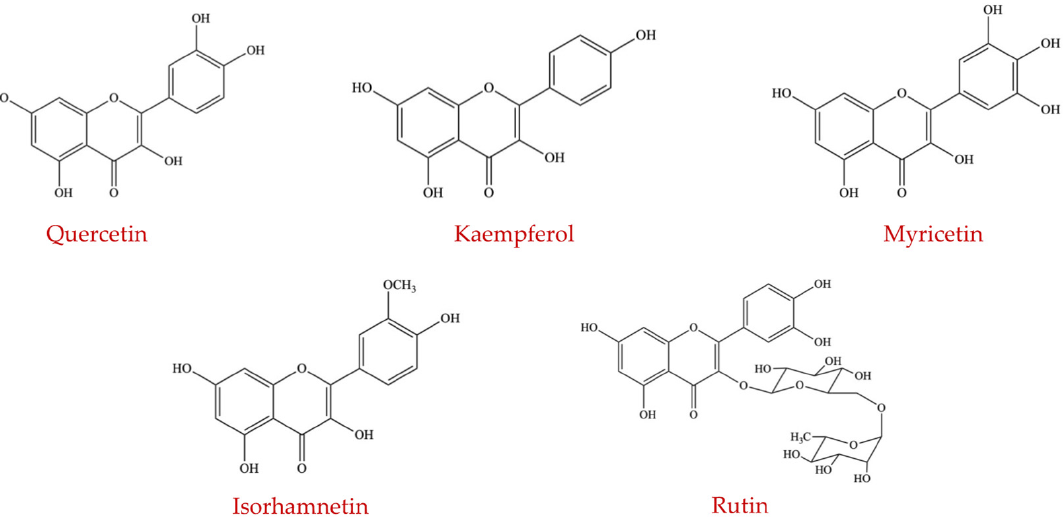
Figure 7. Chemical structures of flavonols (quercetin, kaempferol, myricetin, isorhamnetin, and rutin) (self ‐ generated) .